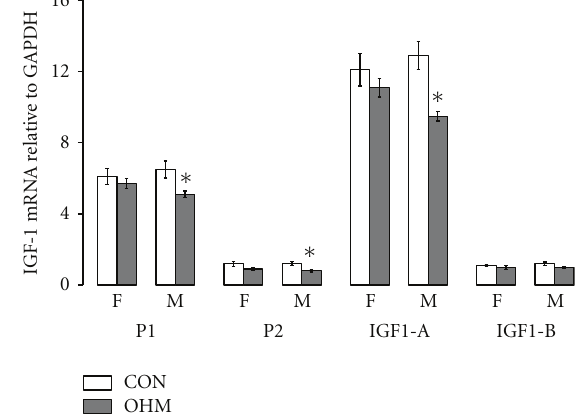
Figure 3: Maternal hyperglycemia decreased hepatic IGF-1 mRNA variants in males. DOL 21 OHM hepatic mRNA variants were expressed as mean ± standard error of the mean relative to GAPDH, for female (F) and male (M) o ff spring, CON in white bars and OHM in grey bars, n = 4 CON female, n = 3 OHM female, n = 5 CON male, and n = 3 OHM male. ∗ P < 0 .